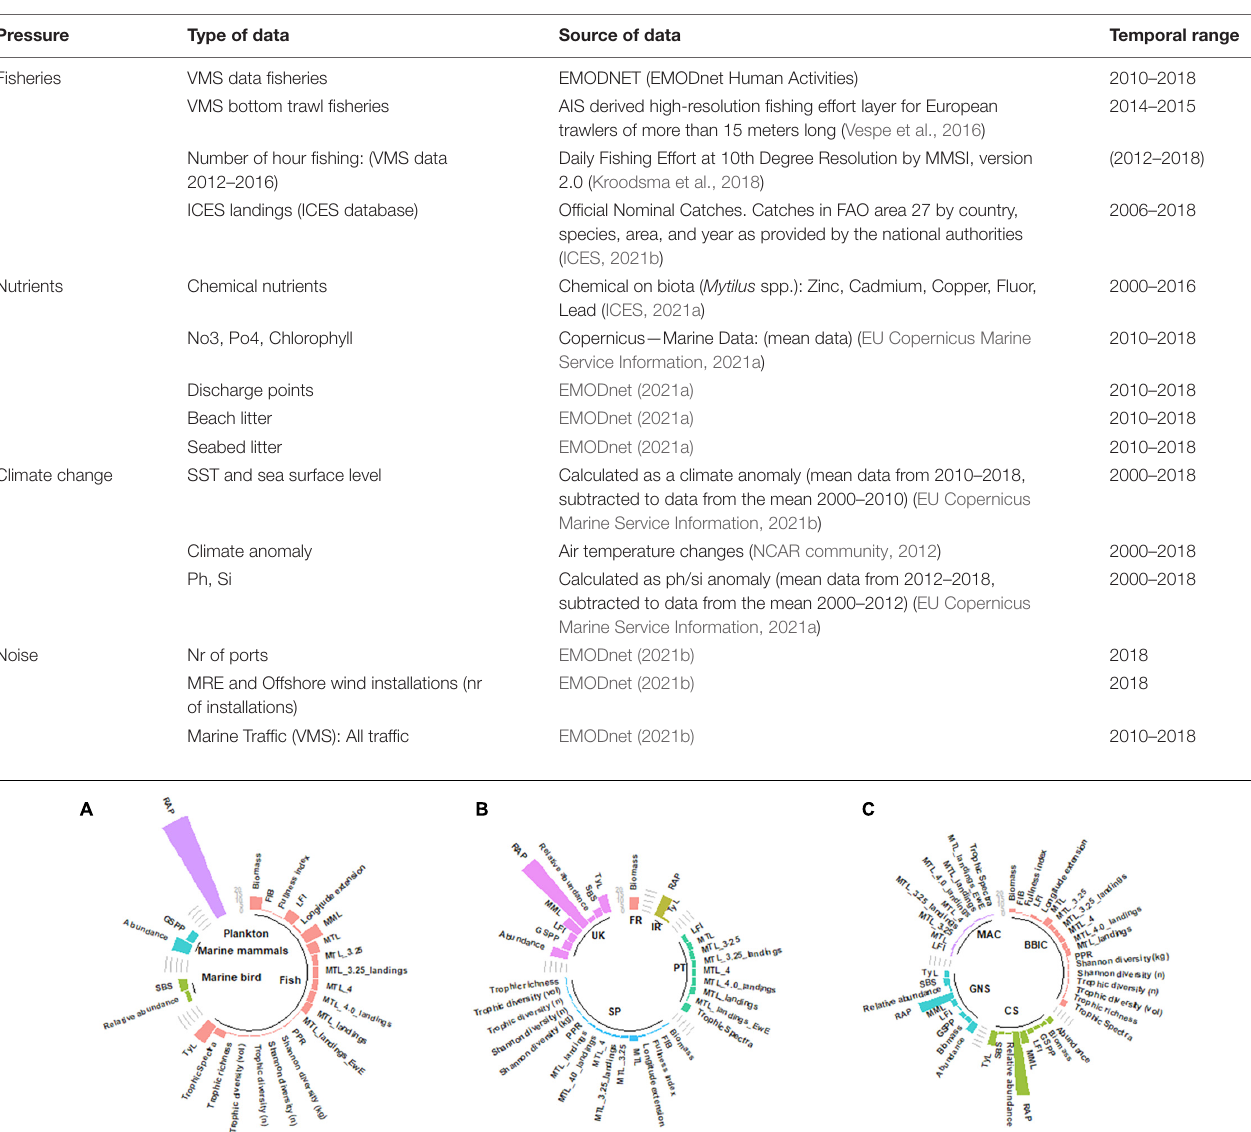
FIGURE 2 | Number of reported criteria per ecosystem element (A) , Member state (B) and subregion (C)